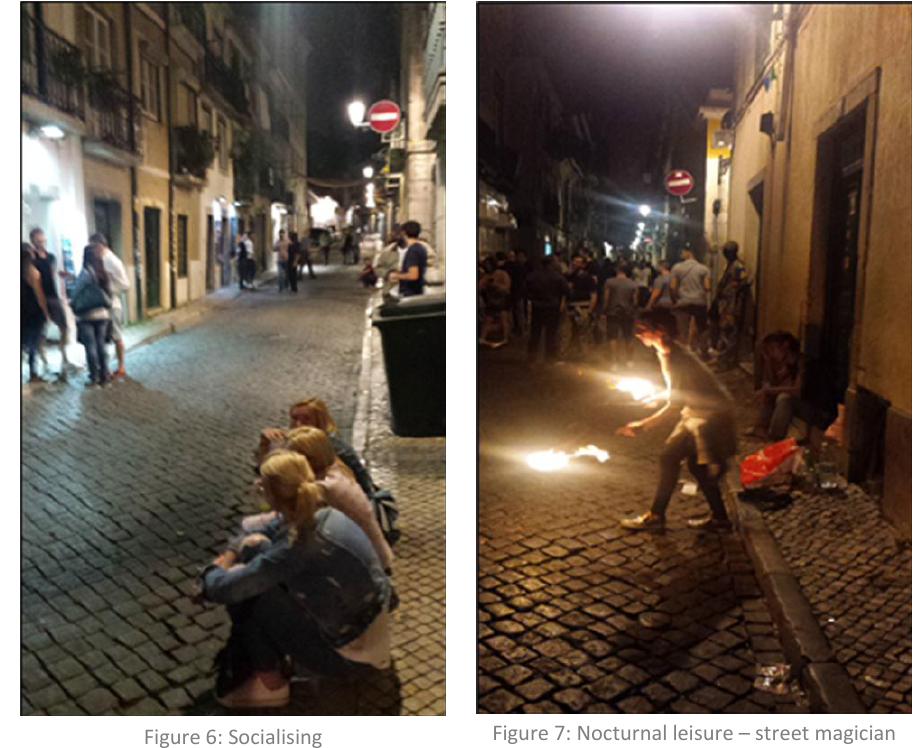
Figure 6: Socialising Source: E.-C. ADOREAN, 2017